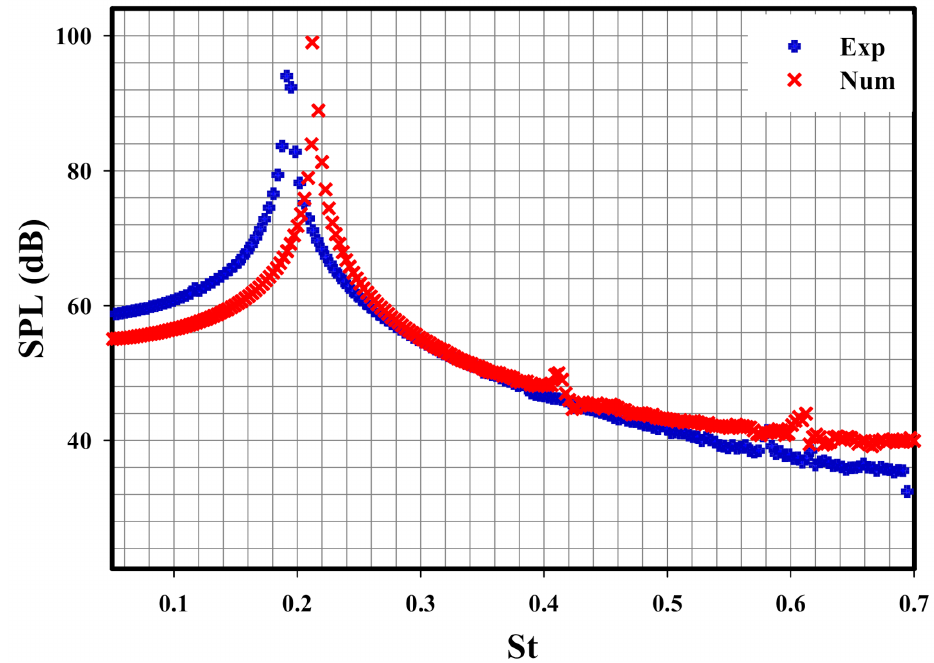
Figure 6. Diagram of the SPL based on the Strouhal number in numerical and experimental [19] studies. Evaluation of the average velocity is an important parameter for examining the flow pattern. Consequently, this study attempts to validate this parameter as one of the most important aerodynamic parameters. The average velocity validation has been achieved at = − 0.25 and X = + 0.25. X = + 0.25 and X = − 0.25 have been two points in the flow: X C C C C · X = − 0.25 in the experiential study equals 0.701, and its minimum value of u mean U 0 C